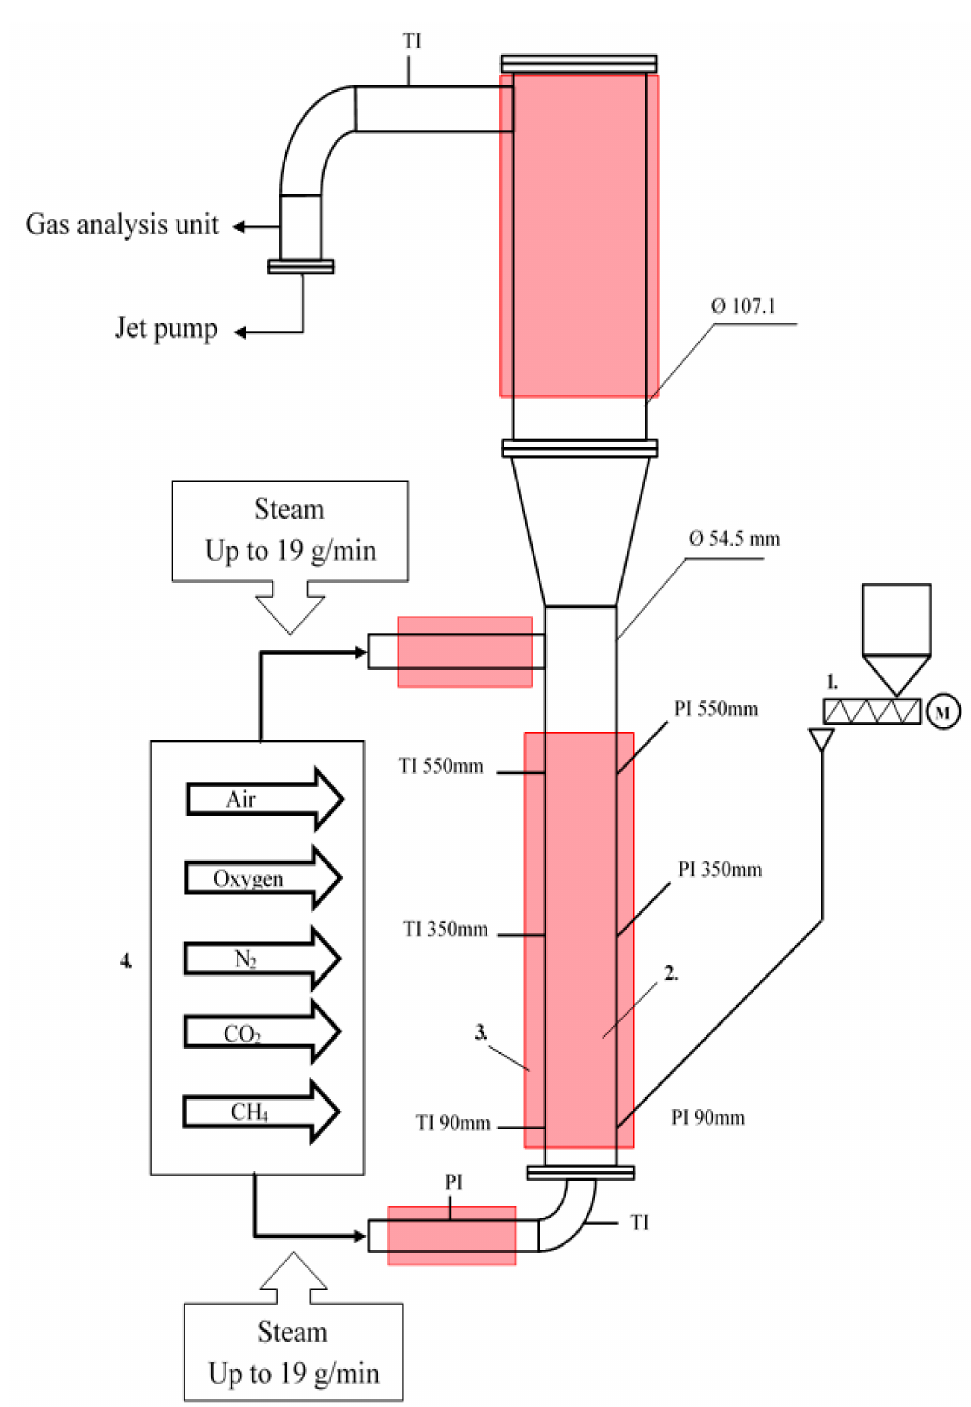
Figure 1. Schematic configuration of the bubbling fluidized bed test rig. 1—screw conveyor for feeding fuel; 2—bubbling fluidized bed reactor; 3—electrical heater; 4—gas distribution